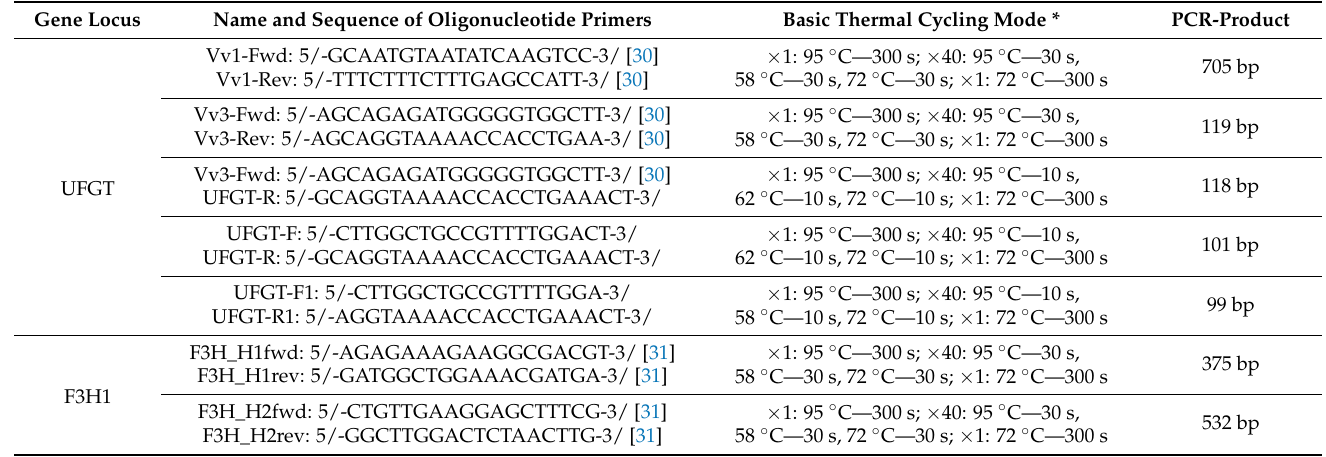
Table 4. Oligonucleotide primers and thermocycling modes used in PCR for the genetic identification of grape varieties and DNA authentication of wines produced from them. Gene Locus Name and Sequence of Oligonucleotide